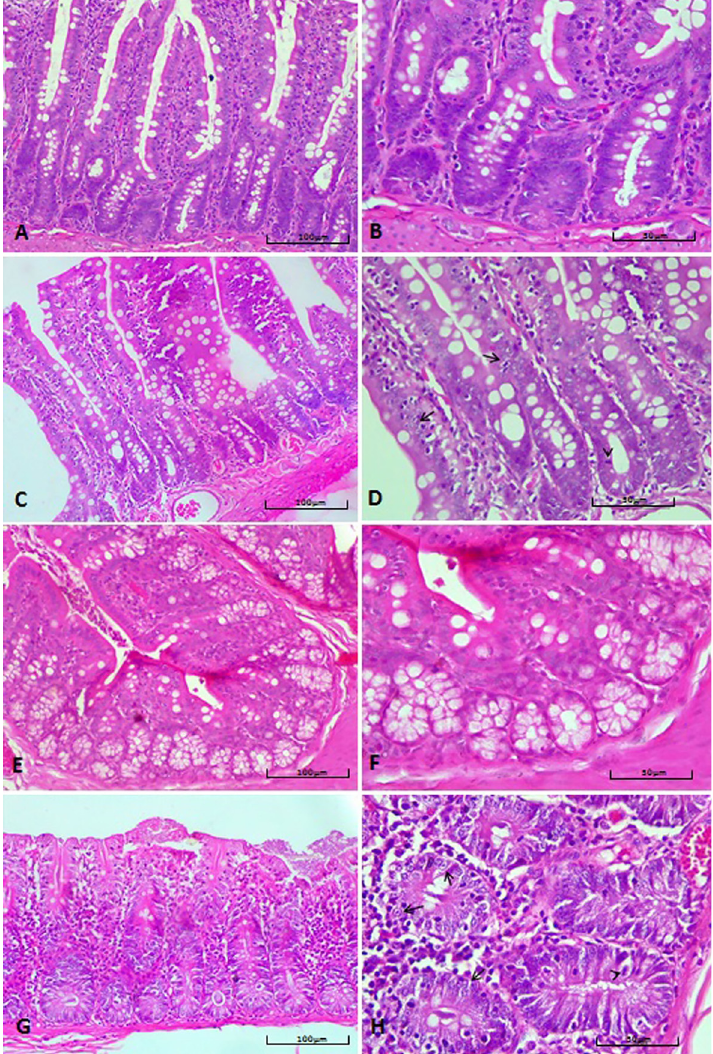
Figure 7. A – D , Microphotographs of the small intestine: A , Normal mucosa (animal from the inhalation control group). B , Detail of the mucosa. C , Mucosa with mild dysplasia. D , Loss of polarity of nuclei, which have a vesicular form with evident nucleoli (arrows) and atypical mitotic fi gure (arrowhead) (animal of the group exposed to moderate concentration of 2,4-dichlorophenoxyacetic acid (2,4-D) by inhalation). E – H , Microphotographs of the large intestine: E , Normal mucosa (animal of the inhalation control group). F , Detail of the mucosa of the large intestine. G , Mucosa with mild dysplasia. H , Absence of goblet cells, loss of polarity of nuclei, which are vesicular with irregular chromatin and evident nucleoli (arrows) and atypical mitosis (arrowhead) (animal from the group exposed to moderate concentration of 2,4-D orally). Hematoxylin-eosin staining; scale bars 100 and 50 m